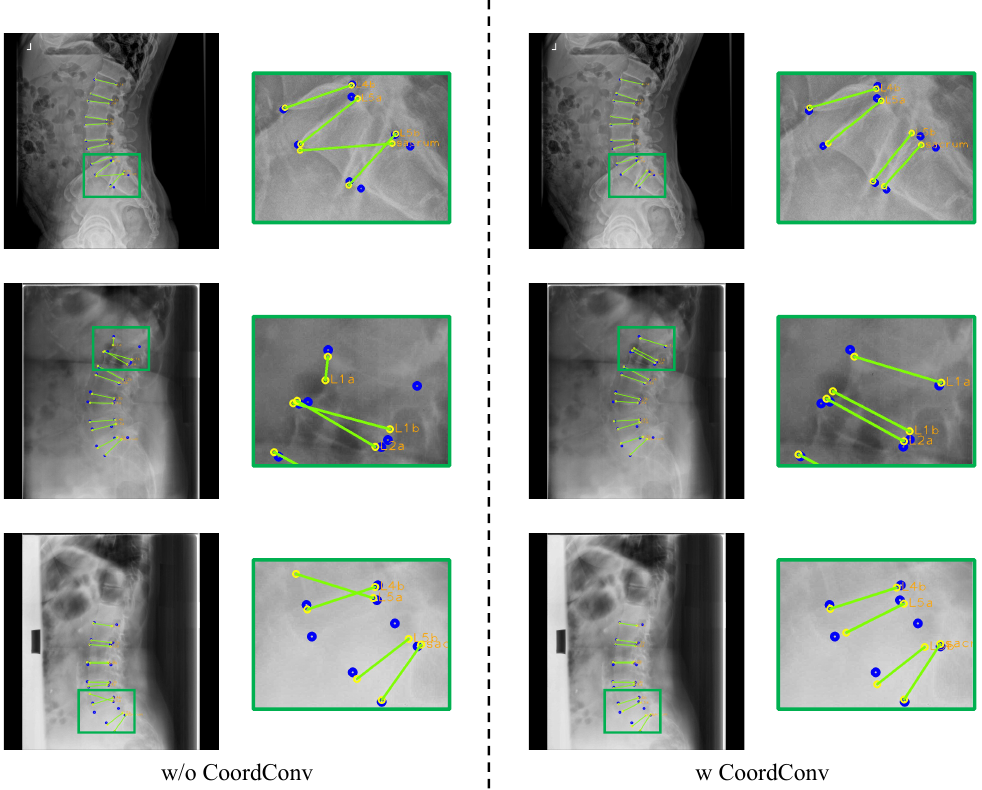
Figure 13. Results of landmark detection depending on CoordConv. The blue circles represent the ground truth, while yellow circles with labels represent predicted results and the green lines represent the line connecting the predicted landmarks of an